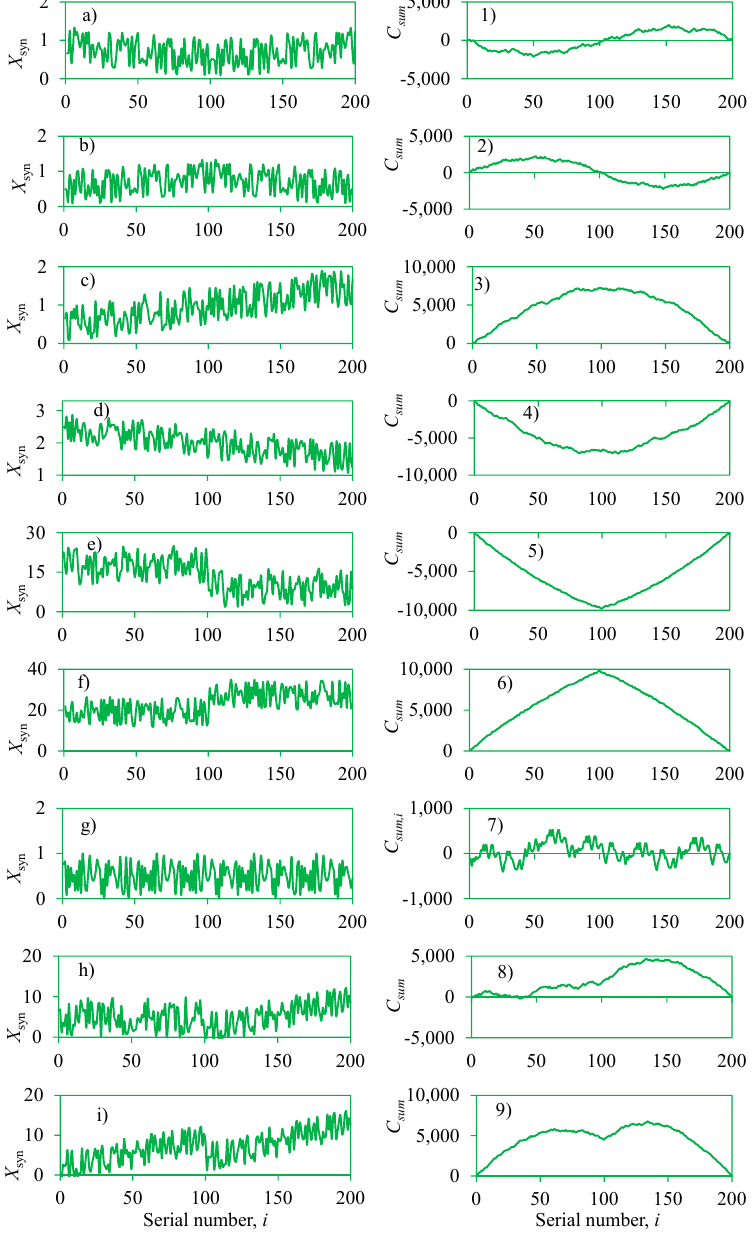
Figure A2. Plots of: ( a – i ) synthetic series X syn of n = 200; and ( 1 – 9 ) the cumulative effects ( C sum , Equation (A1)) of the temporal variations for the corresponding time series.